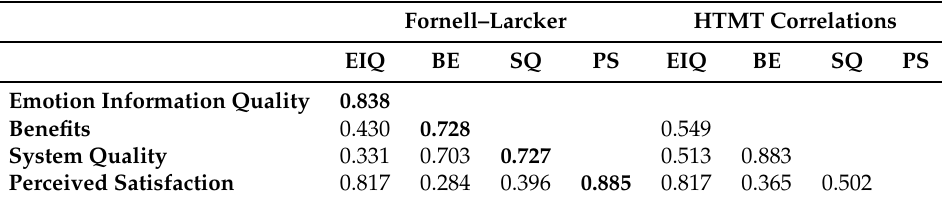
Table 4. Fornell–Larcker method and HTMT